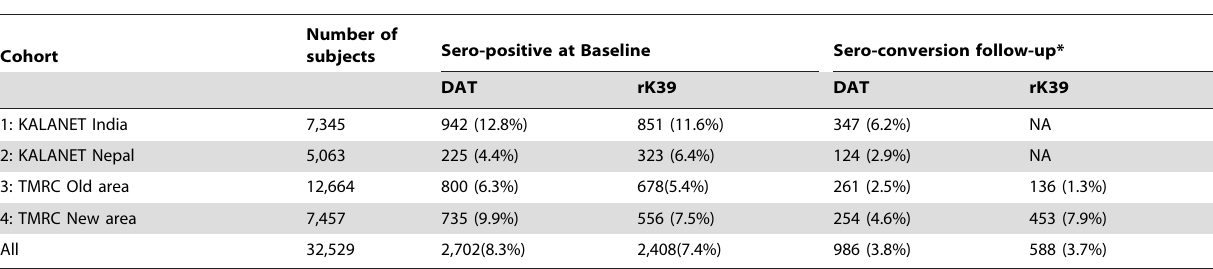
Table 1. Baseline sero-status and seroconversion rates in the 4 study cohorts.